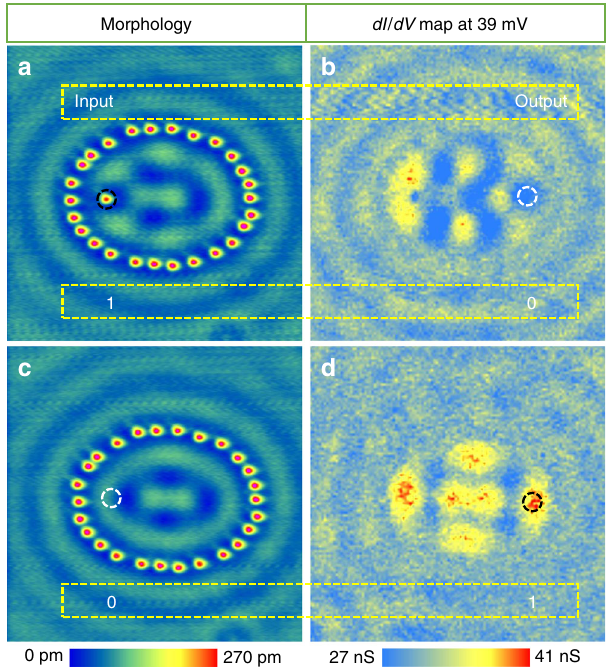
Fig. 5 Inverted mirage and pseudo NOT gate. a Topography for an EQC ( a = 7.6 nm and e = 0.65) with an Fe adatom placed at the left focus. b The corresponding dI/dV map at the bias voltage of + 39 mV for the EQC in a . c Topography of the EQC without the Fe adatom at the left focus. d The corresponding dI/dV map with the same bias voltage of + 39 mV for the empty EQC in panel c. Dashed circles mark the focal positions, for which black means 1 and white means 0.